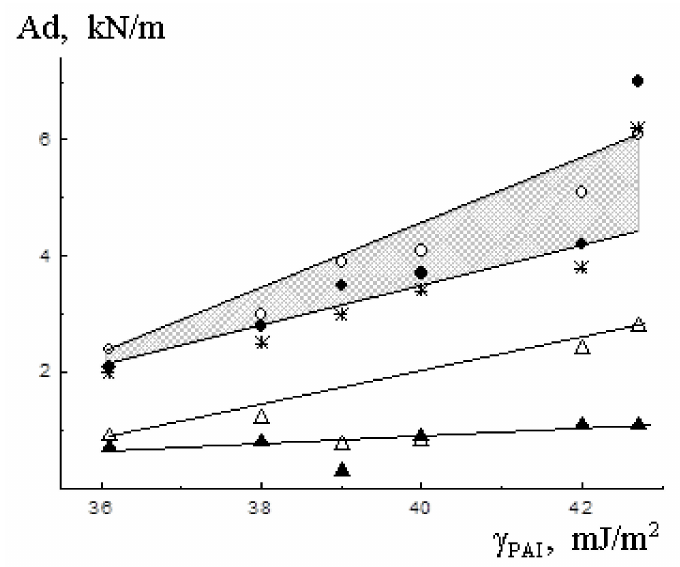
Figure 5. Dependence of the peeling force on the PAI surface energy for di ff erent substrates: ( ◦ ) aluminum, ( • ) steel, ( × + ) glass, ( (cid:52) ) PET, ( (cid:78) )